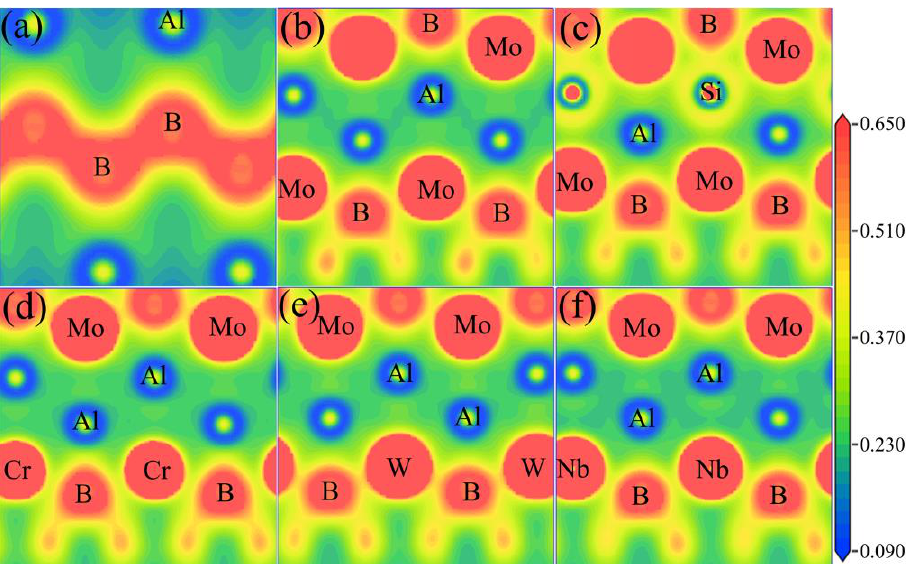
Figure 6. Electron density of the (1 0 0) plane of Mo 4 Al 4 B 4 ( a ), and the (1 0 1) plane of ( b ) Mo 4 Al 4 B 4 , ( c ) Mo 4 Al 3 SiB 4 , ( d ) Mo 3 CrAl 4 B 4 , ( e ) Mo 3 WAl 4 B 4 , ( f ) Mo 3 NbAl 4 B 4.